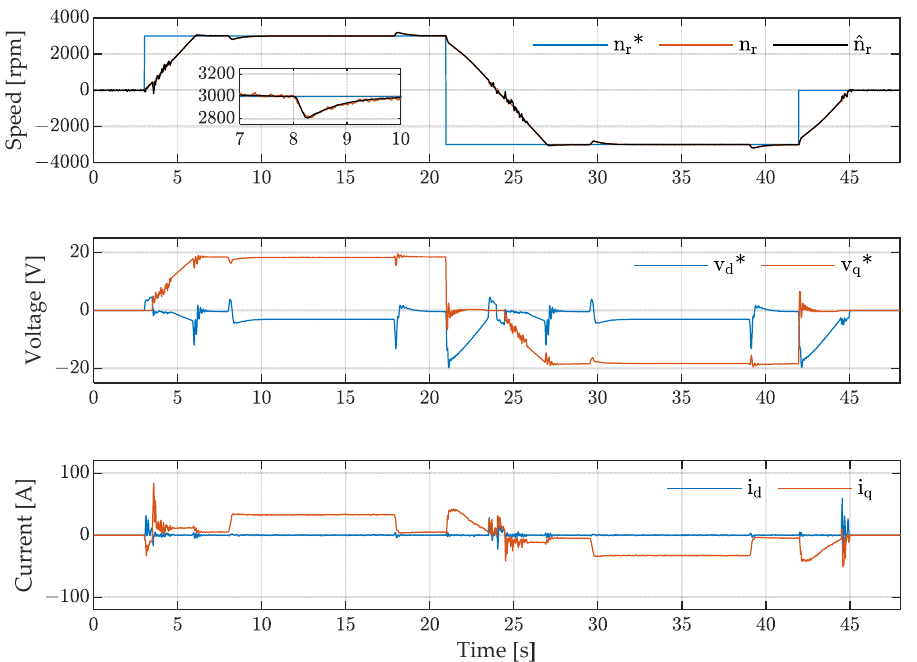
Figure 28. Ramp ‐ up and ramp ‐ down with the nominal reference speed and 50% load applied at Figure 28. Ramp-up and ramp-down with the nominal reference speed and 50% load applied at steady ‐ state: speed, dq voltages, dq currents. steady-state: speed, dq voltages, dq